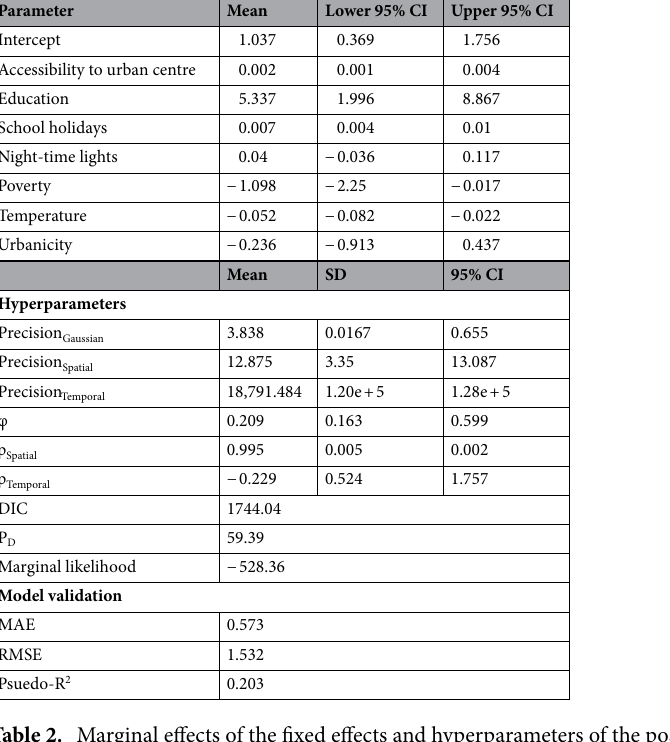
Table 2. Marginal effects of the fixed effects and hyperparameters of the posterior distributions, plus model